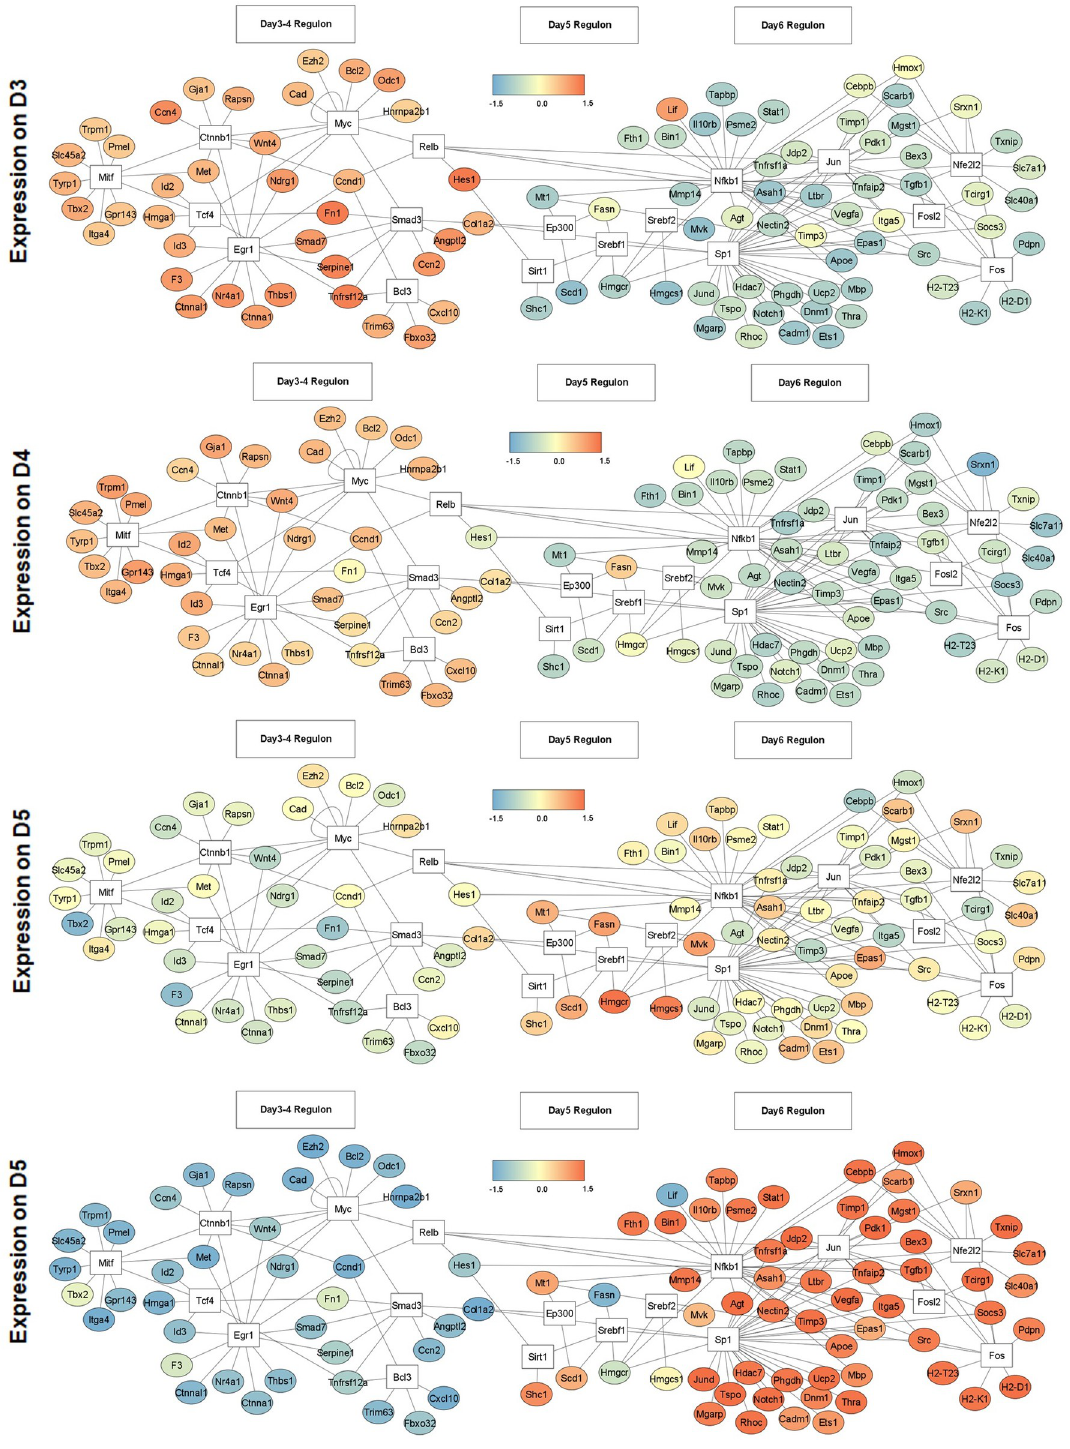
Fig 2. Transcriptionally regulated metabolic networks map for different stages of melanogenesis. DEGs were analysed for the TG enrichment of TF using the TRRUST database on metascape (metascape.org). TF-TG network analysis shows top 7 up-regulated TFs obtained in DEGs analysis on days 3 to 6, along with the expression profile of their TGs. TFs are enclosed in white box and the lines connect each TF to the set of genes regulated by them during pigmentation. TGs are enclosed in circle and colour gradient represents the scaled (row-wise) expression values from the RNA Seq data. Quantitative data are provided in S3 Data. DEG, differentially expressed gene; TF, transcription factor; TG, target gene.